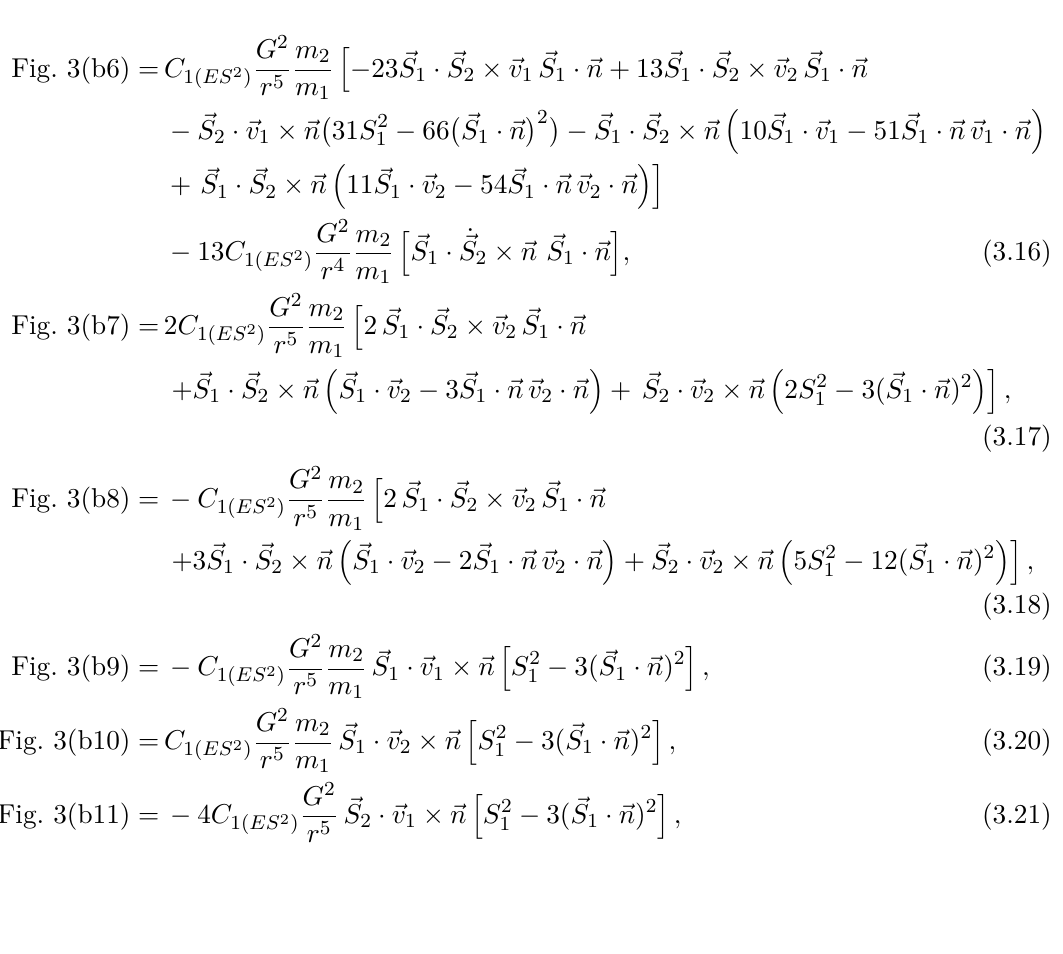
Figure 3 . The Feynman graphs of two-graviton exchange, which contribute to the NLO cubic-in- spin interaction at the 4.5PN order for maximally-rotating compact objects. The graphs should be included together with their mirror images, i.e. with the worldline labels 1 ↔ 2 exchanged. These graphs include all relevant interactions among the spin-induced quadrupole, octupole, and the mass and spin, in particular here at the nonlinear level there are also interactions involving the various multipoles on two different points of the worldline, which add up to interactions that are cubic in the spin, such as a spin dipole and a spin-induced quadrupole or two spin dipoles, on the same worldline, which can already be seen as of the NLO spin-squared sector [12, 14]. Consequently notice that there are nonlinearities originating from gravitons sourced strictly from minimal coupling to the worldline as shown in graphs (b13)-(b15). We also have here two new two-graviton octupole couplings in graphs (b1),